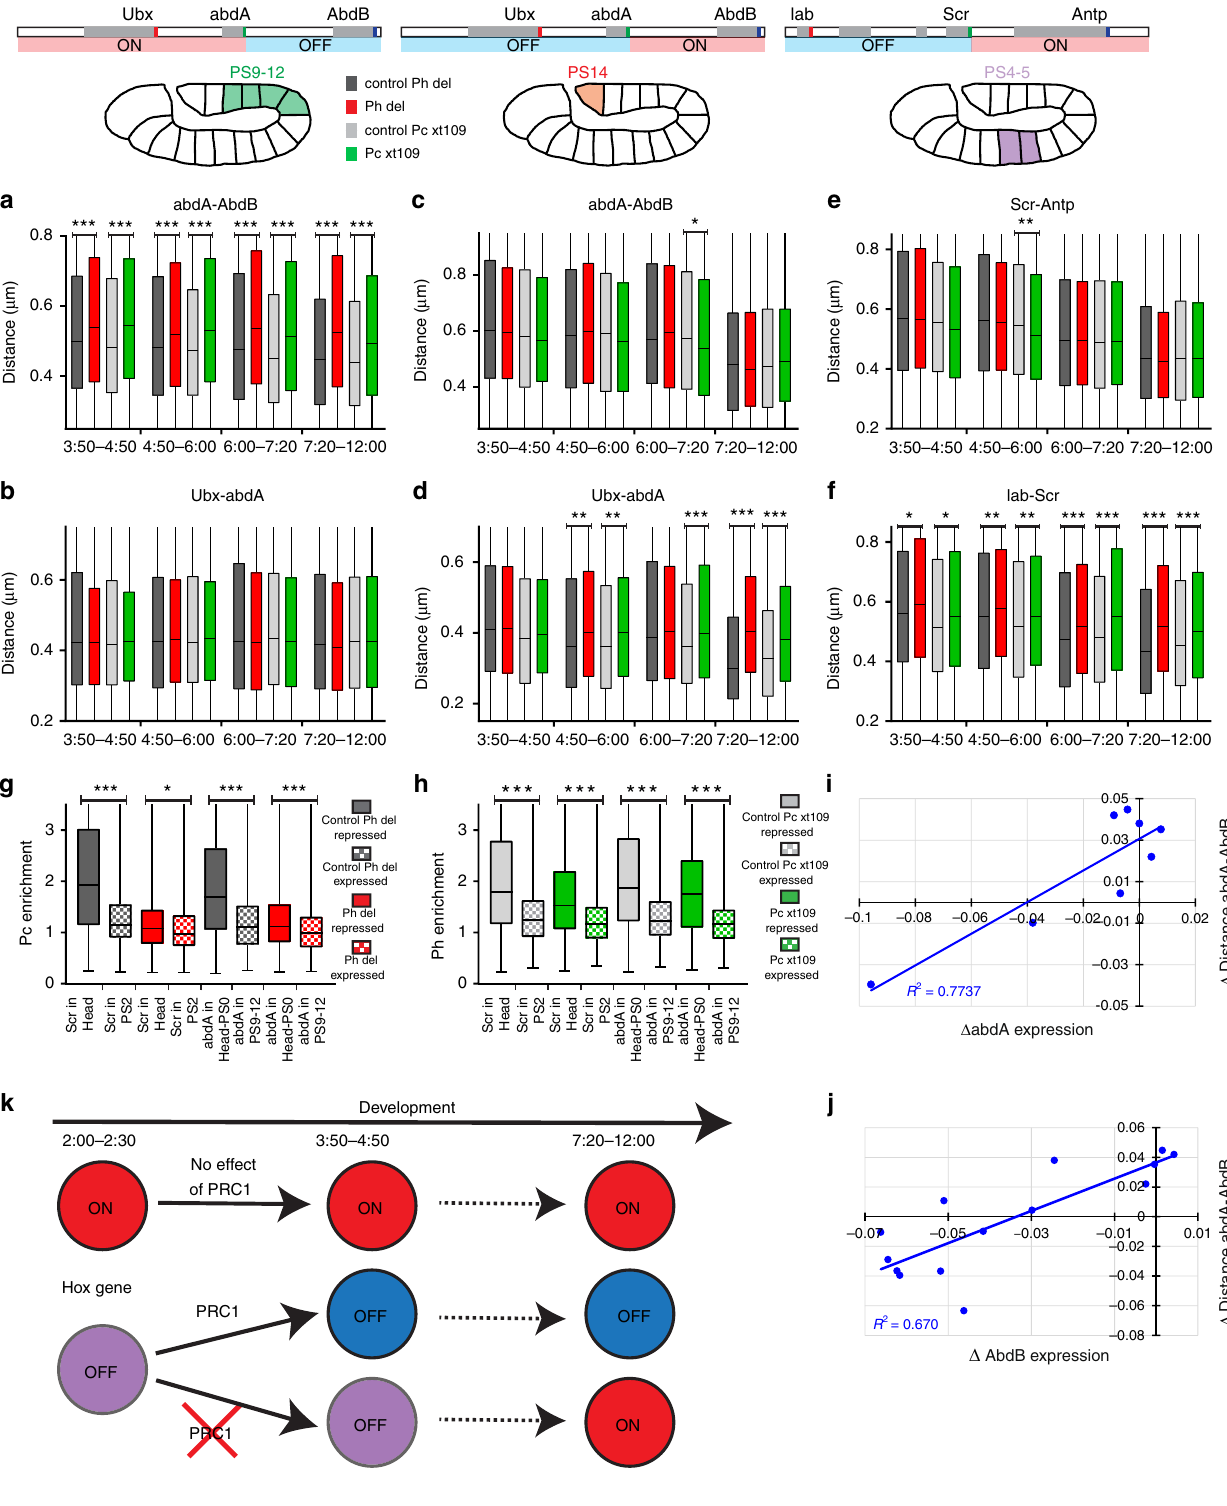
concentration of formamide. Primers used to synthesize DNA FISH probes hybridizing with the promoters of Ubx , abdA , AbdB , lab , Scr , and Antp are listed in Supplementary Table 1. Immuno-DNA FISH experiments were performed using either an anti-Pc rabbit polyclonal antibody (dilution 1/200) or an anti-Ph goat polyclonal antibody (dilution 1/500) developed in our laboratory 40 as primary detection antibodies with A405-conjugated secondary antibodies (anti-rabbit: Thermo Fisher Scienti fi c; A-31556; dilution 1/200 or anti-goat: abcam; Ab 175664;